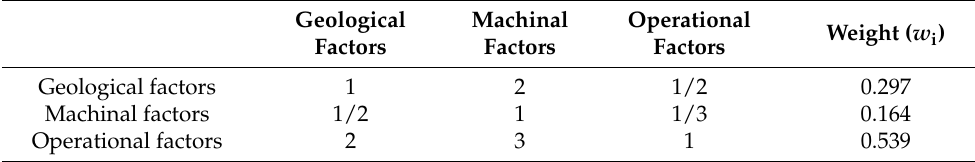
Table 3. Comparison matrix and weight for secondary level.